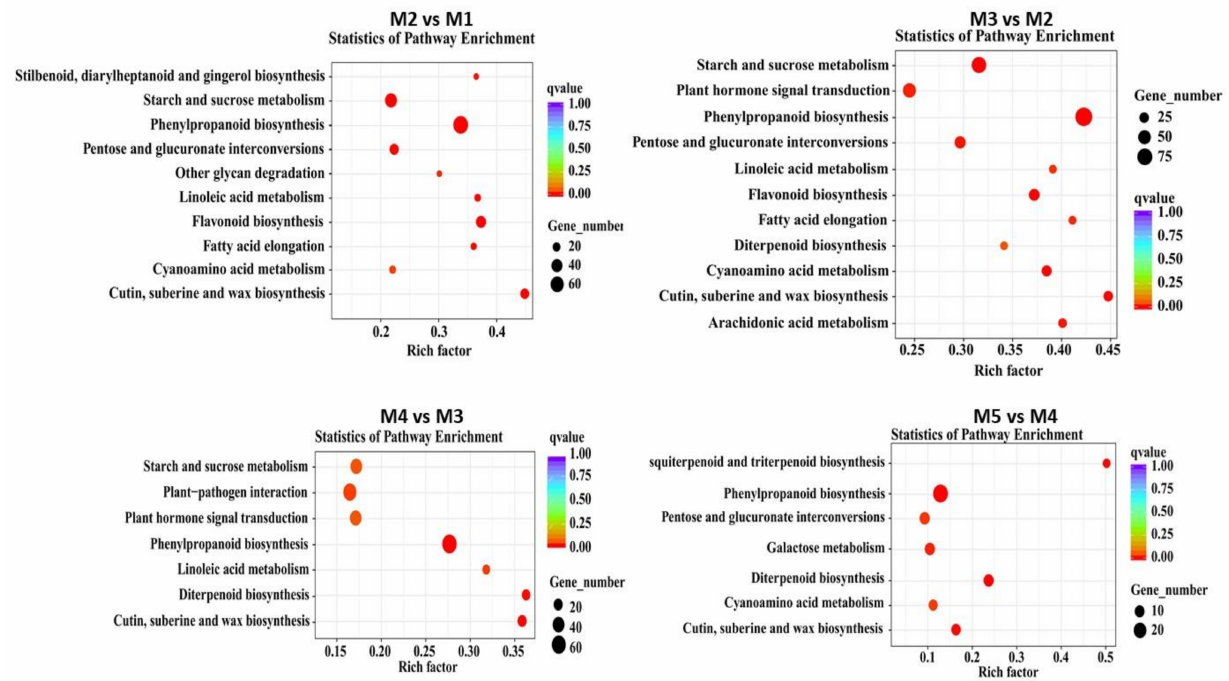
Figure 7. Scatter diagram of the enriched KEGG pathways in D. pectinatum male cones. M1: 8 April, M2: 10 May, M3: 3 June, M4: 3 July, M5: 11